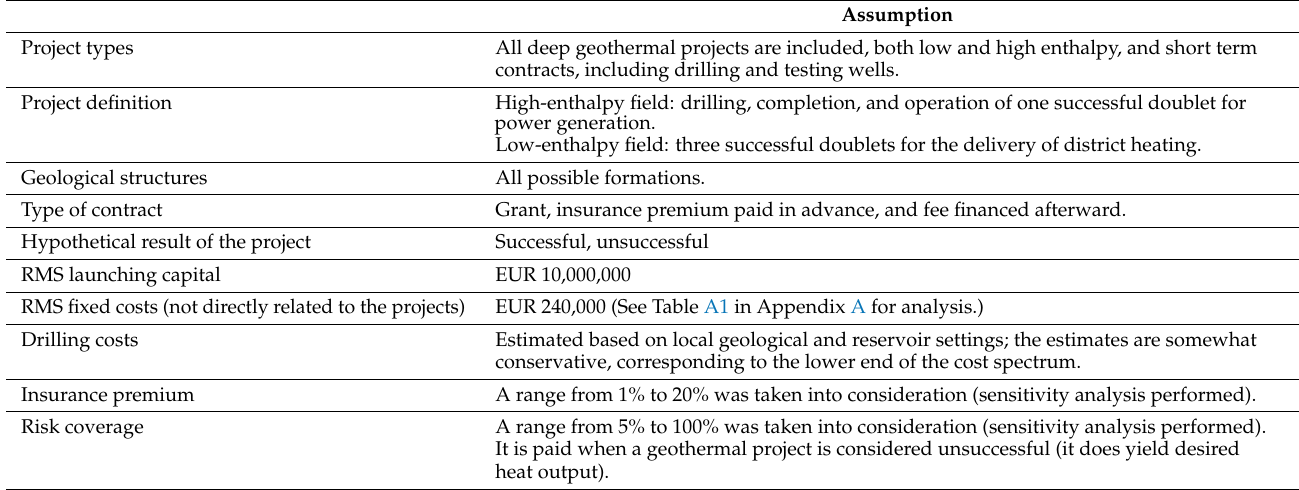
Table 2. Assumptions concerning the geothermal